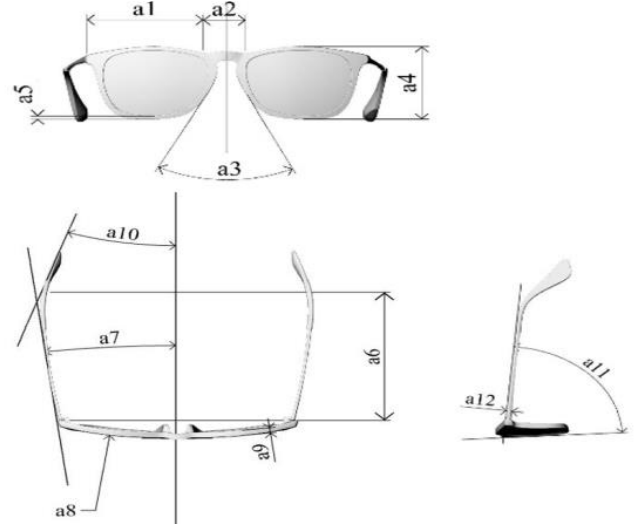
Figure 4. Dimensioning of eyewear.